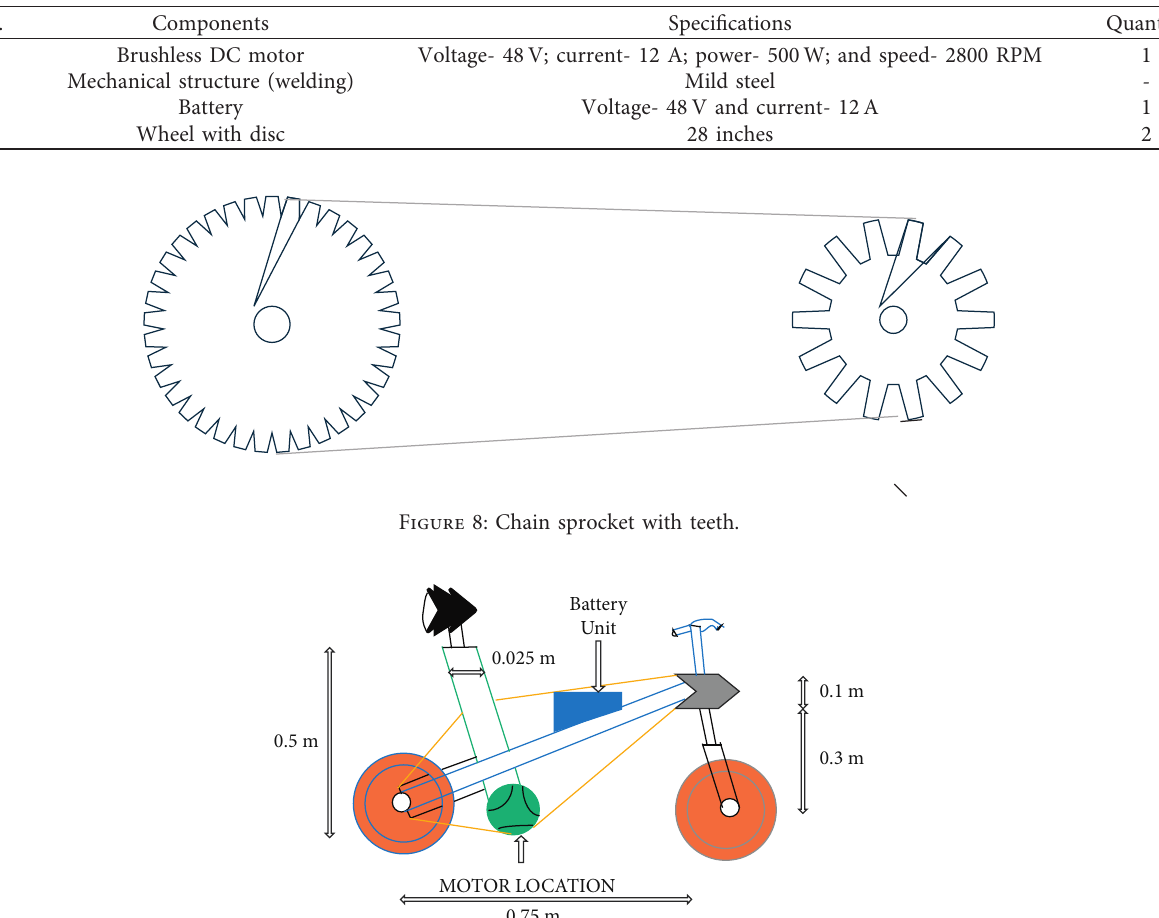
Figure 9: MMS E-Bike design using AutoCAD software.